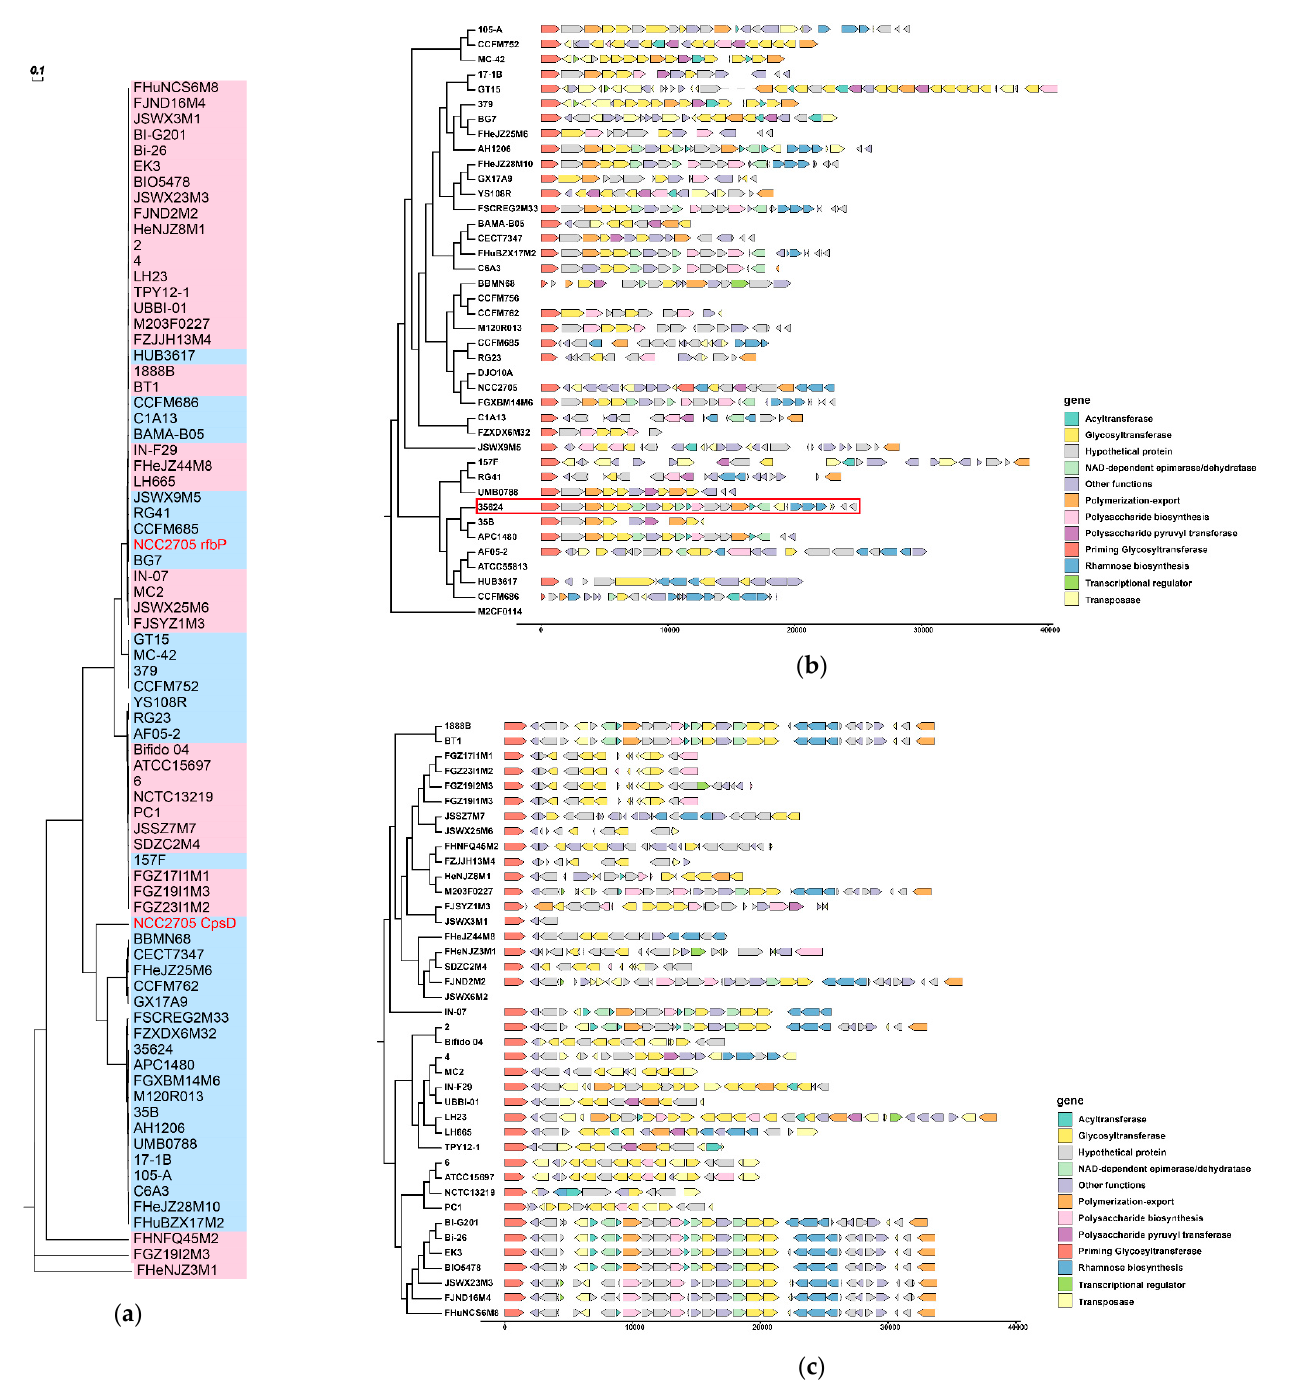
Figure 6. Predicted EPS gene clusters in B. longum : ( a ) Phylogenetic tree of B. longum based on Priming glycosyltransferase. The blue area represents B. longum subsp. longum , the red area represents B. longum subsp. infantis and the red letter highlights two types of p-GTF genes in B. longum subsp. longum NCC2705. Predicted EPS gene clusters in B. longum subsp. longum ( b ) and B. longum subsp. infantis ( c ). The red square highlights the EPS gene clusters, which were used as templates to perform BLAST